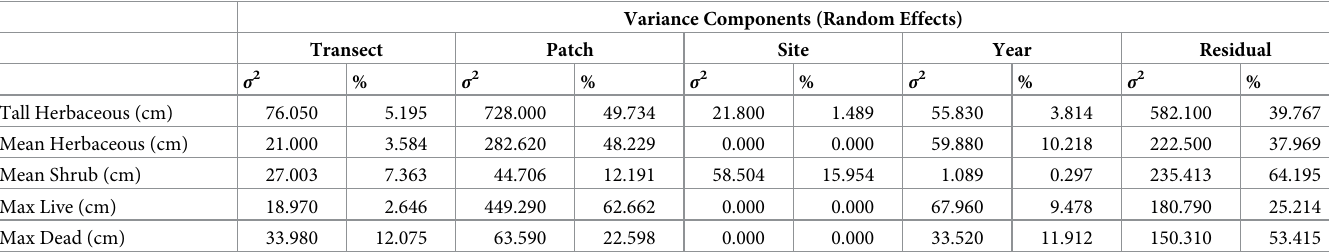
Table 4. Variance components.